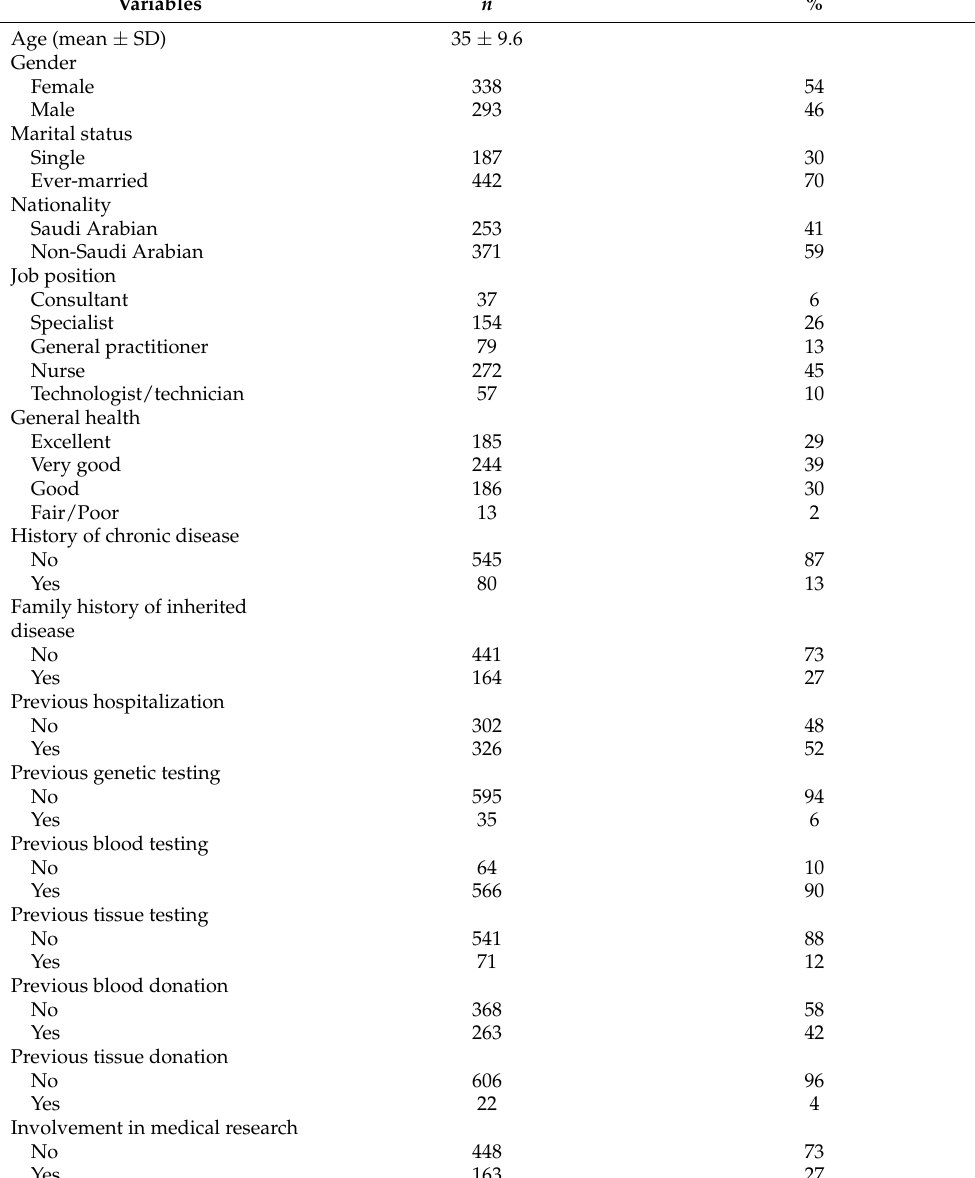
Table 1. Characteristics of the study participants and biobanking-related variables ( n =